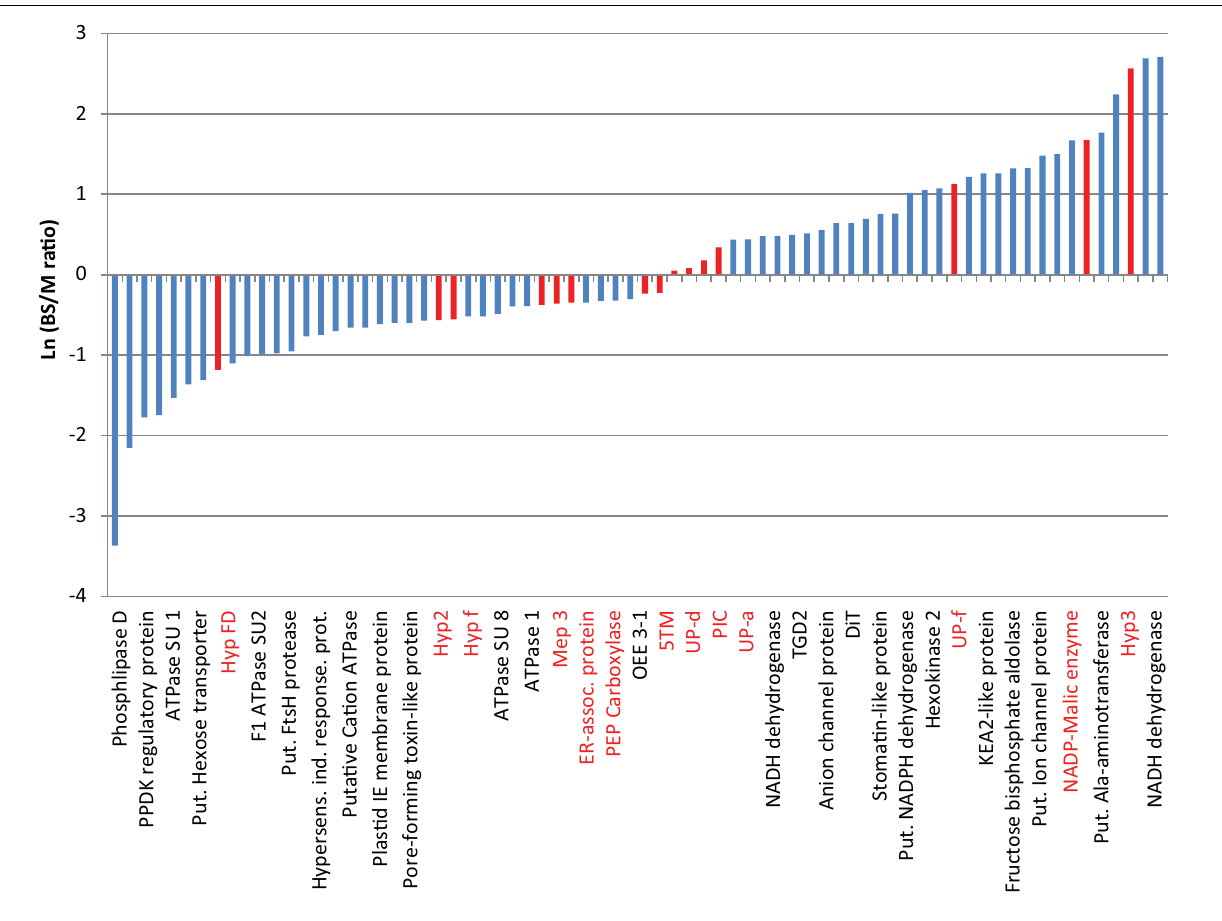
FIGURE 2 | Differences in the relative abundance of proteins based on the bundle sheath: mesophyll ratio of their spectral ion counts. Data are based on values shown inTables S3 and S4 in Supplementary Material. Except for known controls, only membrane-associated proteins are